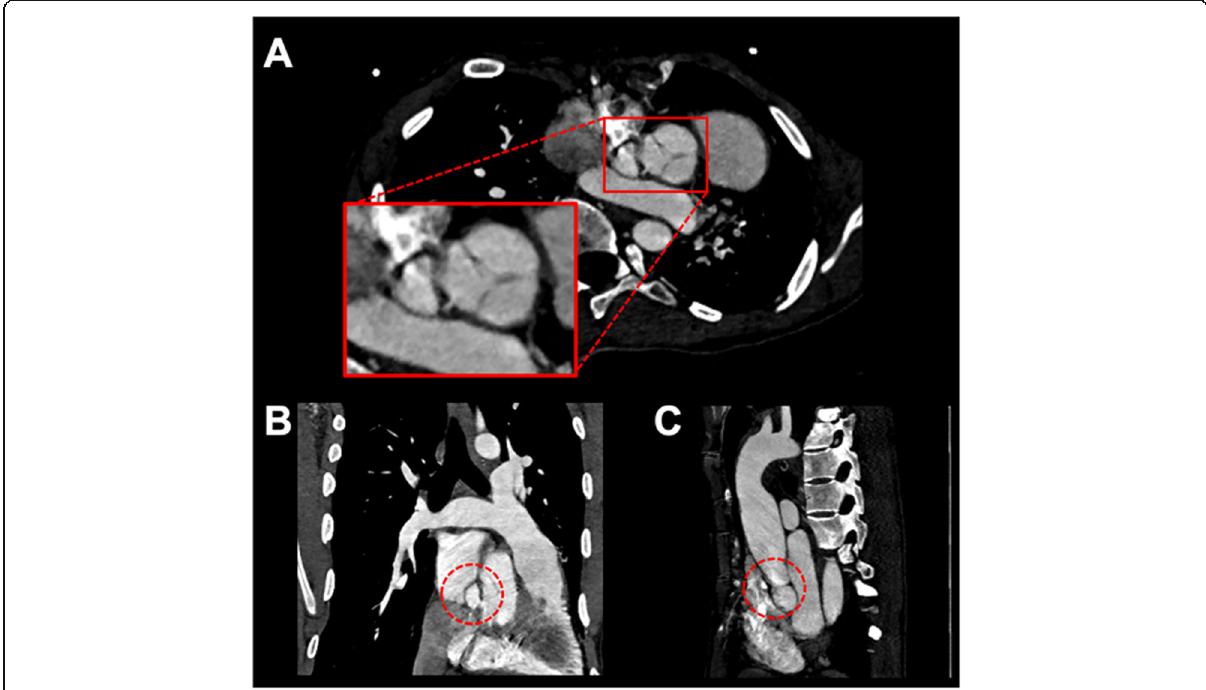
Fig. 1 Cardiac Computed tomography ( a : axial, b : coronal and c : sagittal reformats) demonstrates an enlarging 20×17×12mm pseudoaneurysm arising from the aortic annulus surgical anastomosis caudal to the non-coronary cusp with neck measuring 3mm post Bentall procedure (red